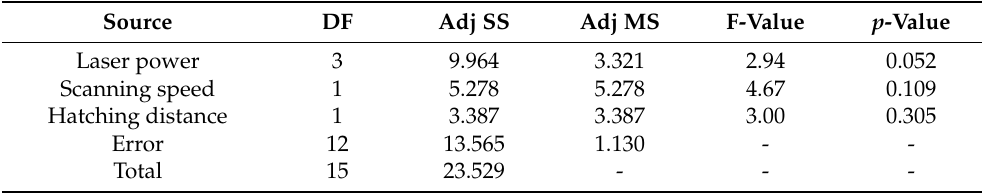
Table 3. Results from the regression analysis of the